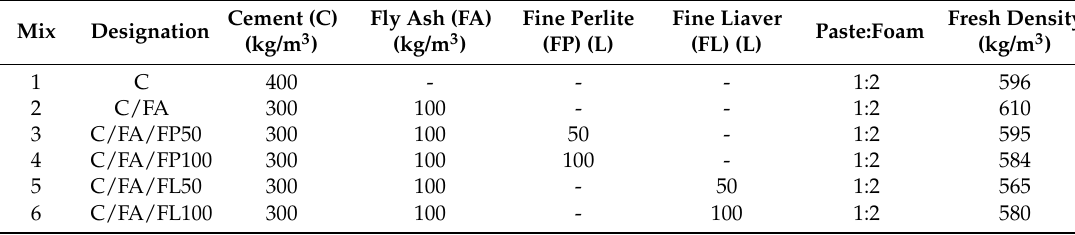
Table 2. Mix compositions of foamed concrete.